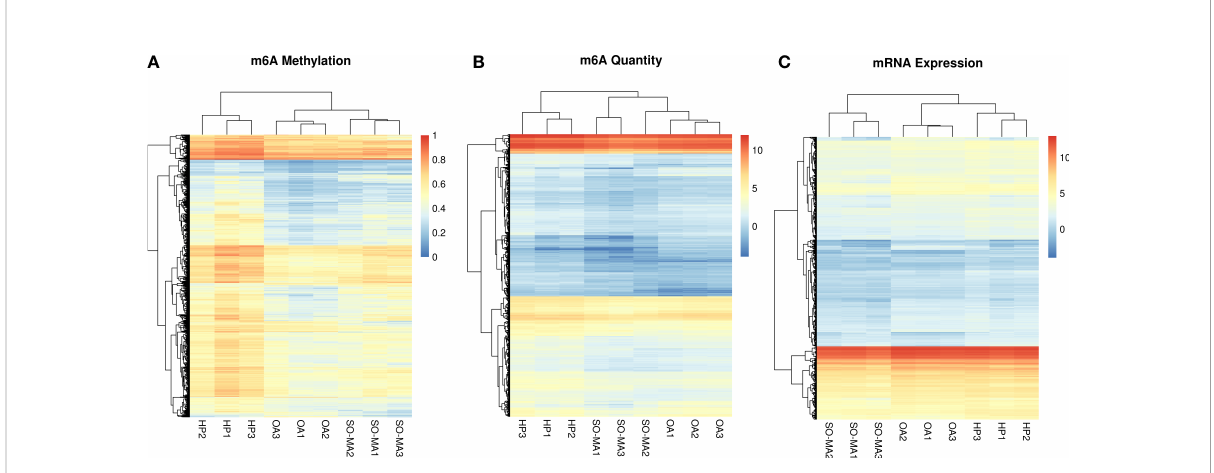
FIGURE 2 The clustering analysis heatmaps of m 6 A methylation (A) , m 6 A quantity (B) , and mRNA expression (C) in the SO/MA, HP, and OA